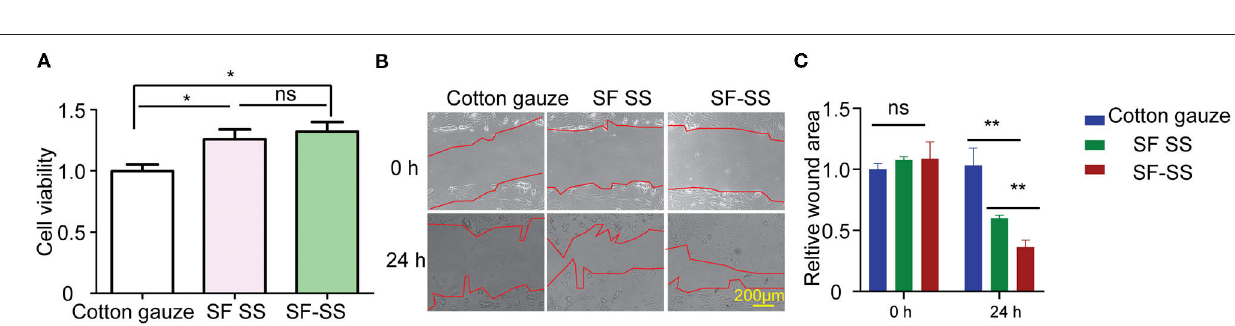
FIGURE 2 | SF SS and SF-SS hydrogel promote BJ cell growth. (A) BJ cell viability was detected by CCK-8 after treatment with SF SS and SF-SS hydrogel. (B) BJ cell migration after scratch and treatment with SF SS and SF-SS hydrogel was recorded by microscope. (C) The quantity of relative wound area in Figure B of cell migration by Image J. Data is shown as mean ± standard deviation ( n = 3). ns, no significant difference, * p < 0.05, ** p <